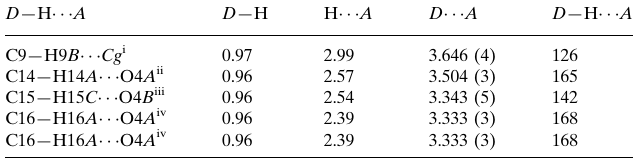
Hydrogen-bond geometry (A˚ , (cid:2)